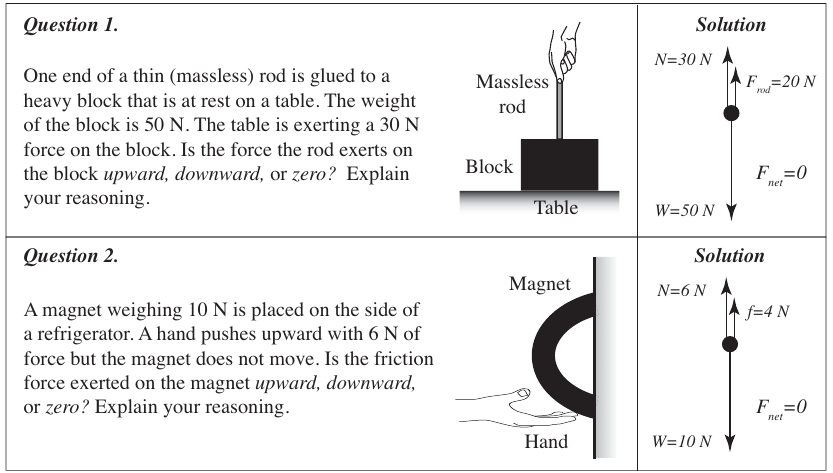
FIG. 1. A pair of questions on forces and Newton ’ s laws. The free-body diagram for question 2 illustrates vertical forces only; horizontal forces acting on the magnet in question 2 are not relevant to the case of static friction and therefore are not